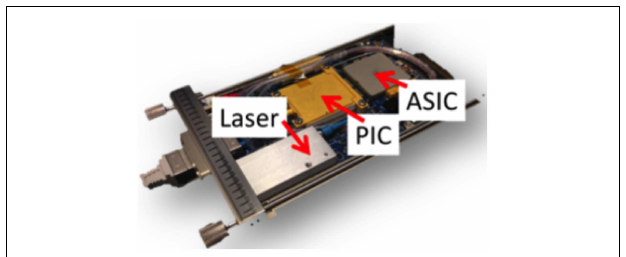
FIGURE 27 | 100-Gb/s coherent CFP module using silicon